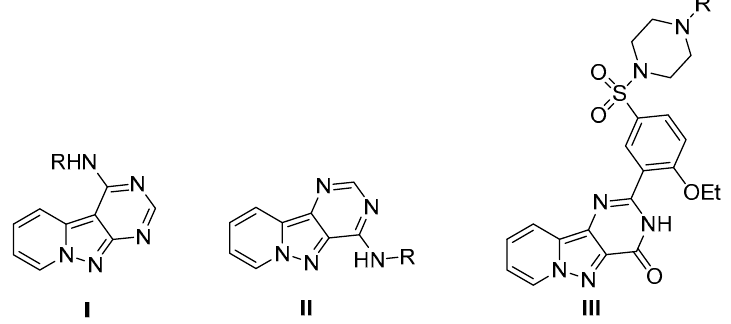
Figure 1. Some representative pyrido[1 ′ ,2 ′ :1,5]pyrazolo[3,4- d ]pyrimidine derivatives I and